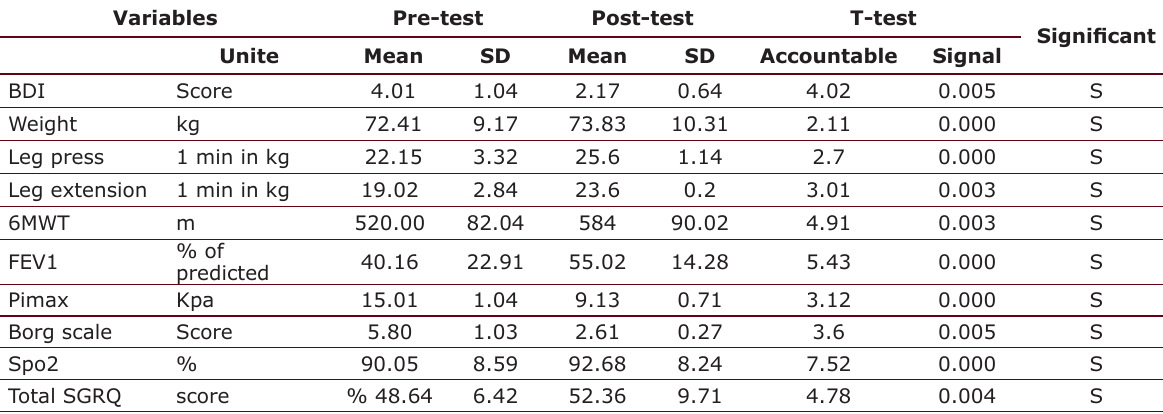
Table 4. The Mean, SD, T-test, signal, and Significant of Pre and post-tests for the experiment